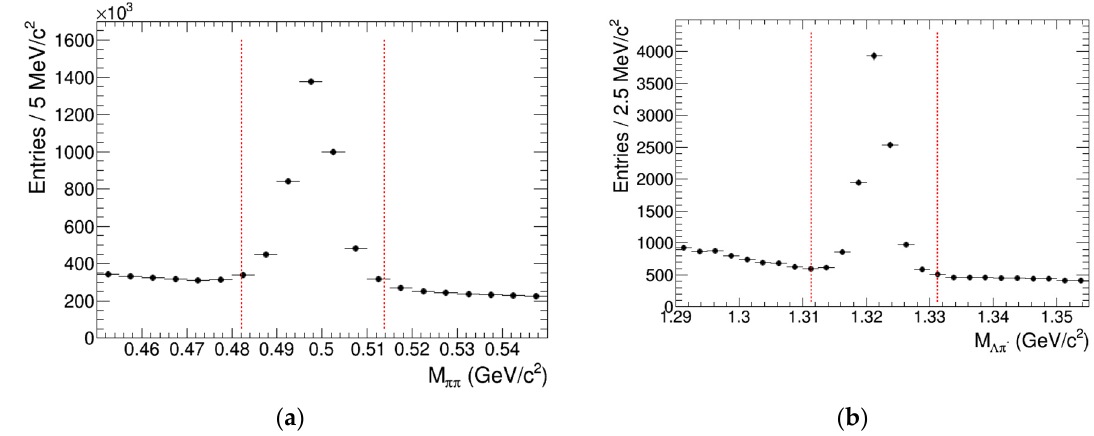
Figure 2. The invariant mass distributions accumulated for π + π− ( a ) and π − Λ ( b ) pairs in Au+Au collisions at √𝑠 (cid:3015)(cid:3015) = 11 GeV. The vertical dashed lines show the 3 σ mass intervals for the selection of 𝐾 𝑠0 and Ξ − candidates. Figure 1. Another option for estimation of the background would be the accumula-